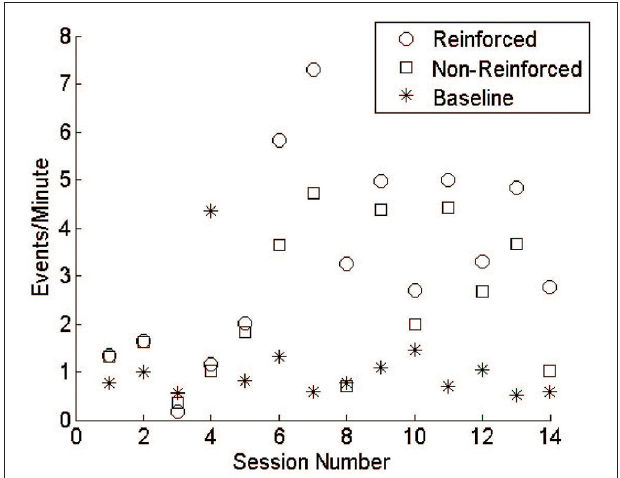
FIGURE 7 | LFP conditioning results in free behavior. During early sessions reinforceable events during R and NR remained close to baseline responding. Events during R and NR increased above baseline by session 6 and fluctuated over the subsequent sessions. Training was not performed daily, as emphasis was given to system design and refinement.